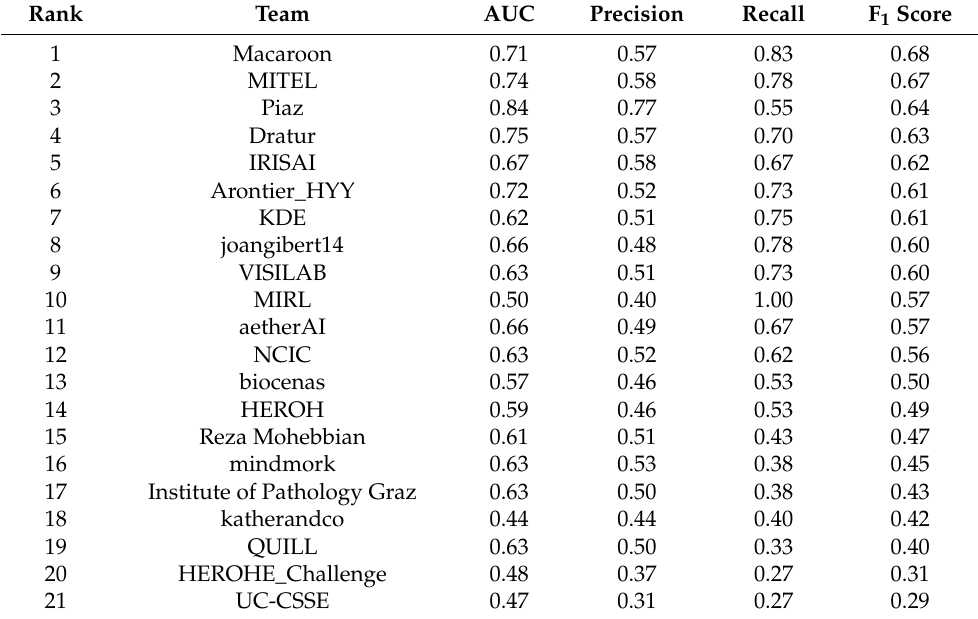
Table 3. Final classification of the HEROHE Challenge according to F (cid:2869) score.